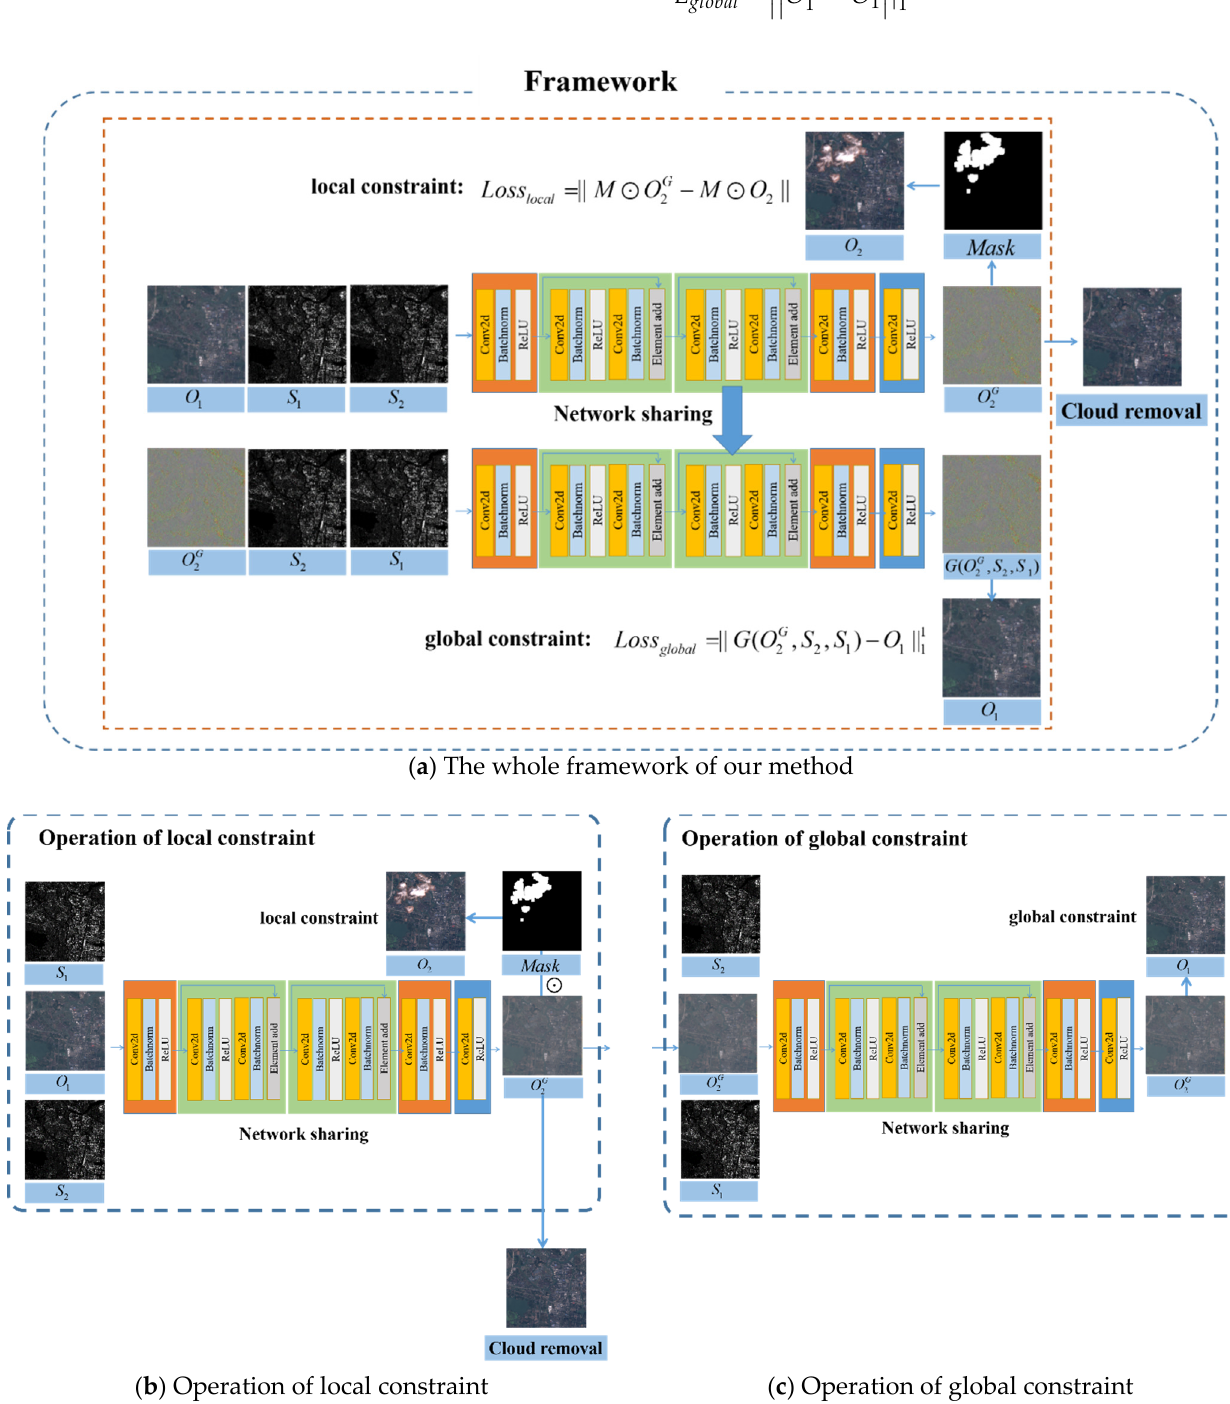
Figure 1. The flowchart of our method.